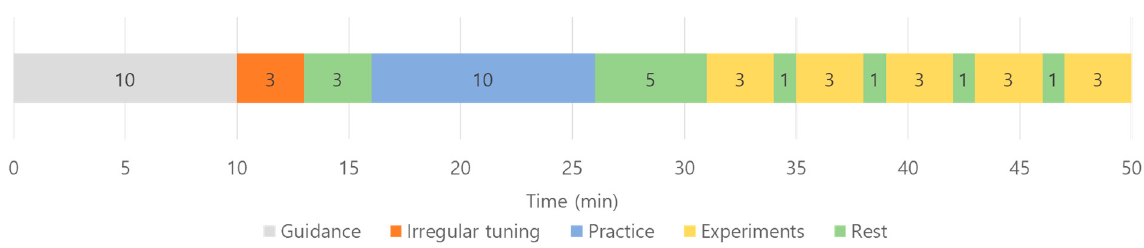
Figure 12. Experiment environment.